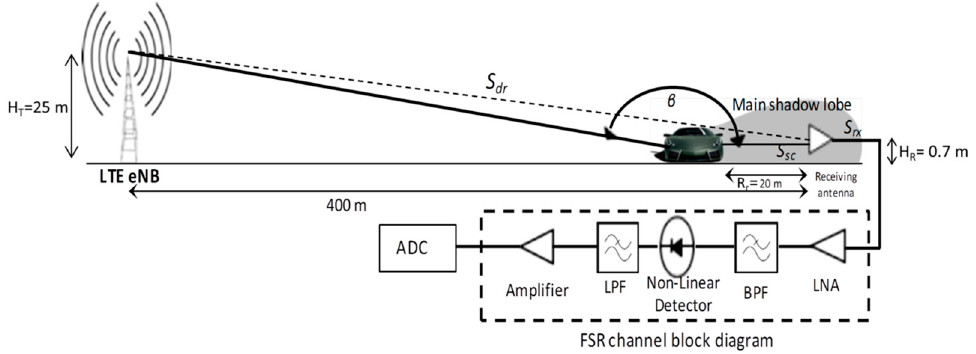
Figure 6. Passive Forward Scattering Radar sensor system based on LTE signal transmission.